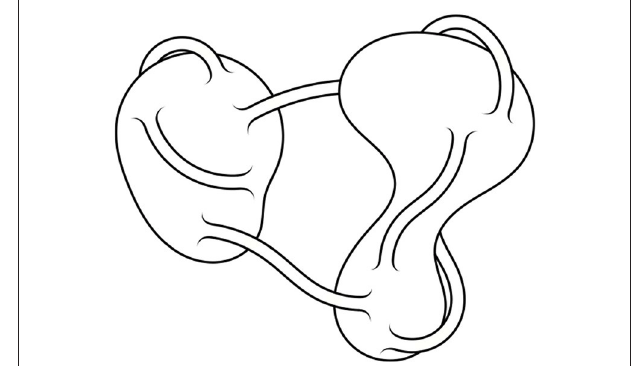
FIGURE 7 | Large universes connected by wormholes—figure adapted from Fischler and Susskind